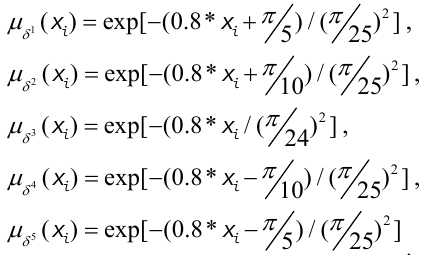
Fig. 2. Simulation